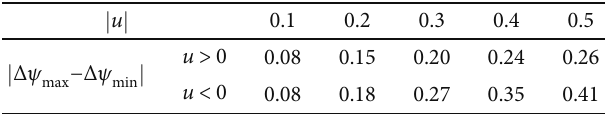
Figure 12: Teeth pressure loads in the subcritical state ( Re = 10000 , π = 1 : 3 , M Table 3: Maximum deviation of di ff erent teeth pressure loads in the subcritical state ( Re = 10000 , π = 1 : 3 , M U = 0 : 23 , and C = 0 : 067 ). u j